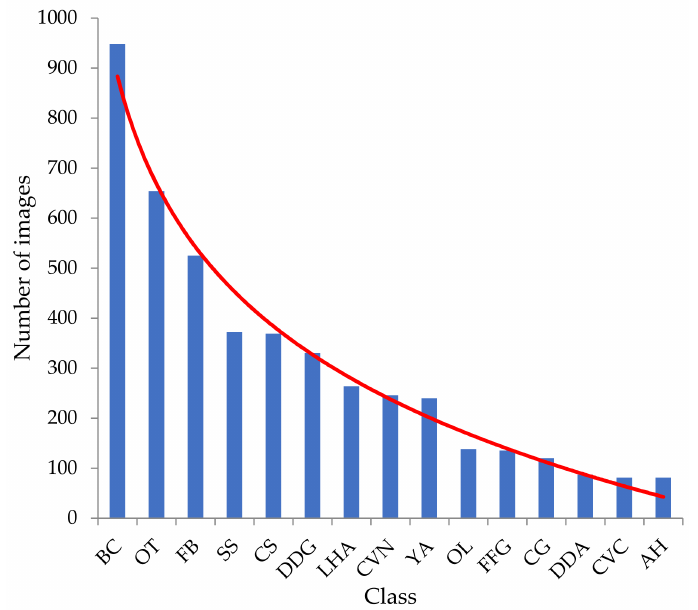
Figure 9. Long tail distribution of remote sensing ship dataset. The abscissa is the ship class, and the ordinate is the number of images. The red line represents the long-tailed distribution trend.